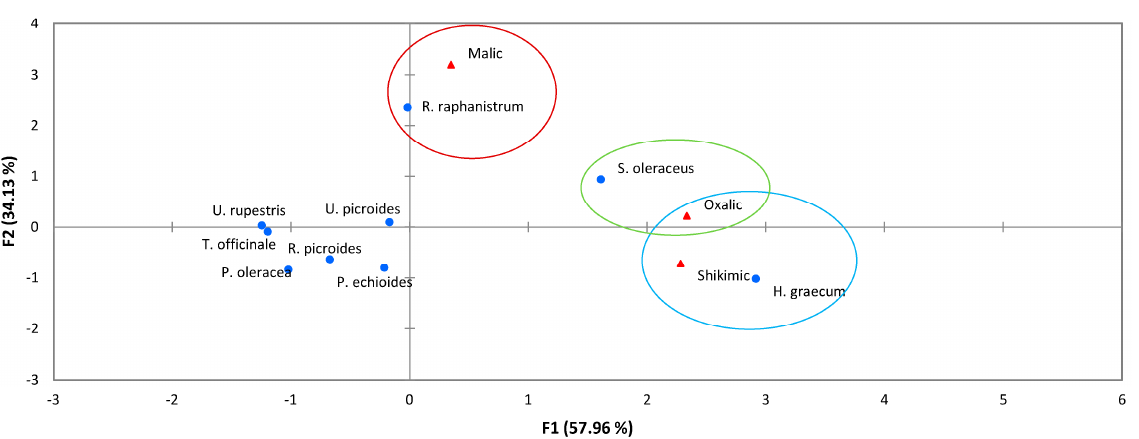
Figure 2. Principal Component Analysis (PCA) of organic acids present in wild edible plants, WEPs. In this way, the highest contents of malic acid were reported in Raphanus raphanistrum and Sonchus oleraceus (580 and 415 mg/100 g, respectively) [42,61]. The WEPs in which the highest amounts of oxalic acid were found, in decreasing order were: Hymenonema graecum > Sonchus oleraceus > Raphanus raphanistrum , with concentrations between 972 and 706 mg/100 g [42,61]. Regarding shikimic acid, two plants stood out for their contents: Hymenonema graecum and Sonchus oleraceus , with 244 and 166 mg/100 g, respectively; the other WEPs where this acid was found had values of below 100 mg/100 g